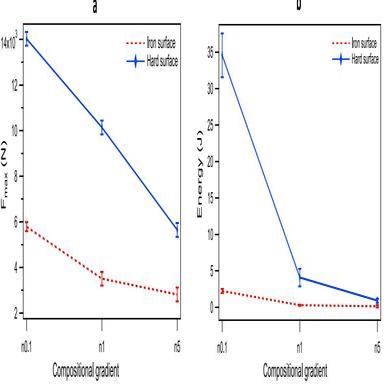
Changes in the a) impact fracture force and, b) fracture energies for samples impacted from iron and hard surfaces.